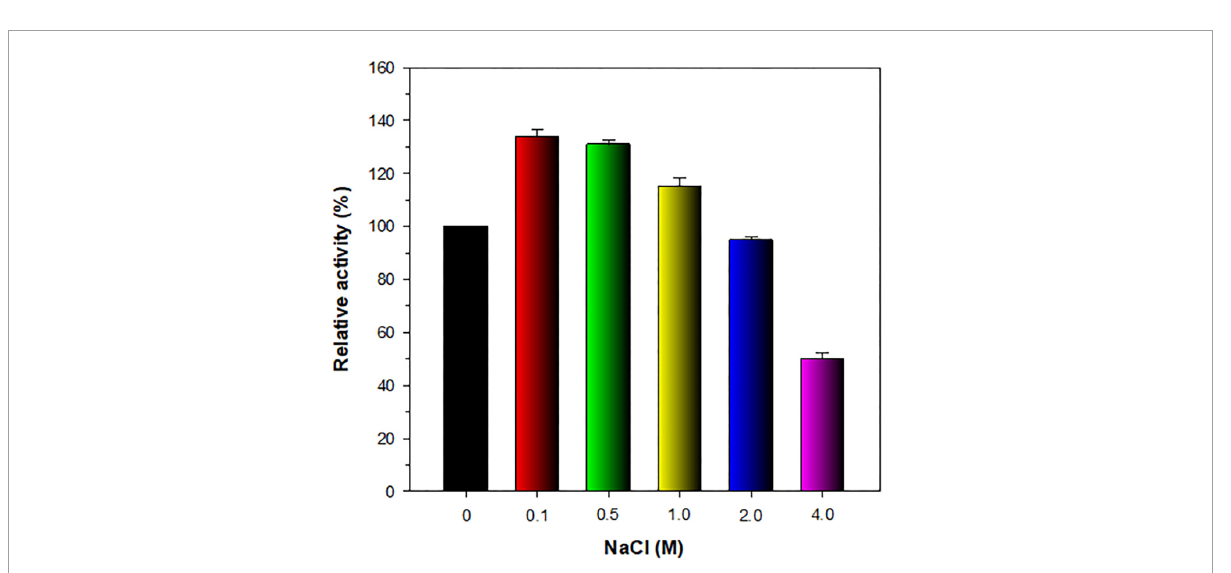
FIGURE6 Effect of NaCl on the endo- β -1,4-glucanase activity of recombinant endo- β -1,4-glucanase (rGluL). The salt tolerance of rGluL was evaluated by reacting the enzyme with CMC for 10 min in the assay mixture including NaCl at concentrations of 0, 0.1, 0.5, 1.0, 2.0, and 4.0 M. The values are mean ± SD of triplicate